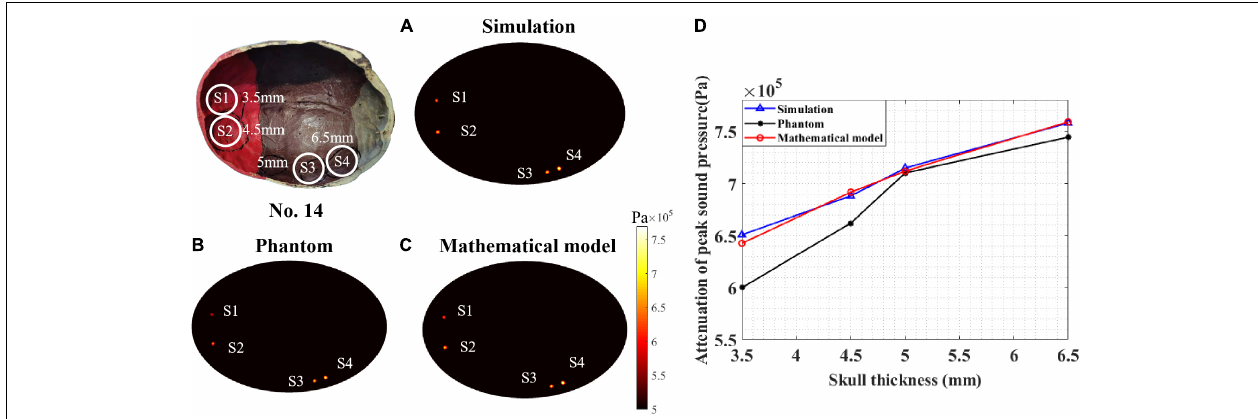
FIGURE 9 | Peak sound pressure at different test points for skull No. 14. (A) Simulation experiment result. (B) Phantom experiment result and (C) mathematical model result. (D) The attenuation of peak sound pressure with different skull thicknesses. The thickness of test points S1, S2, S3, and S4 are 3.5, 4.5, 5, and 6.5 mm, respectively.